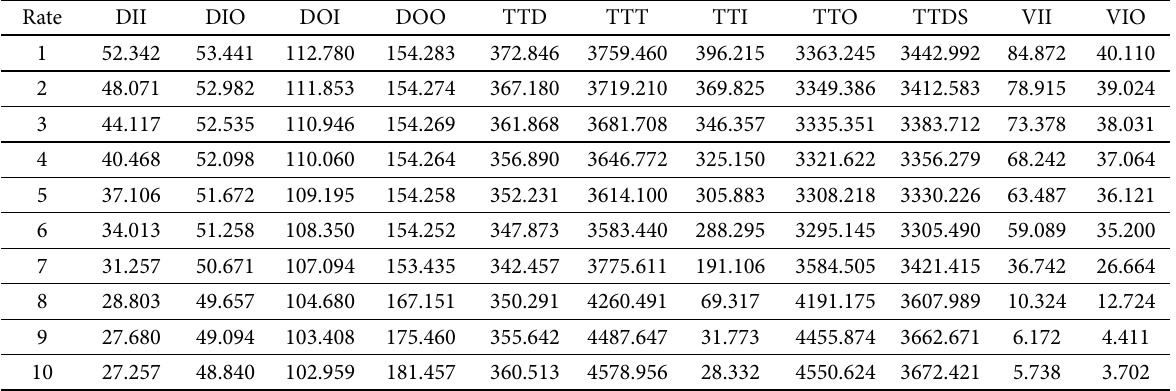
Table 3. Sensitivity analysis of area